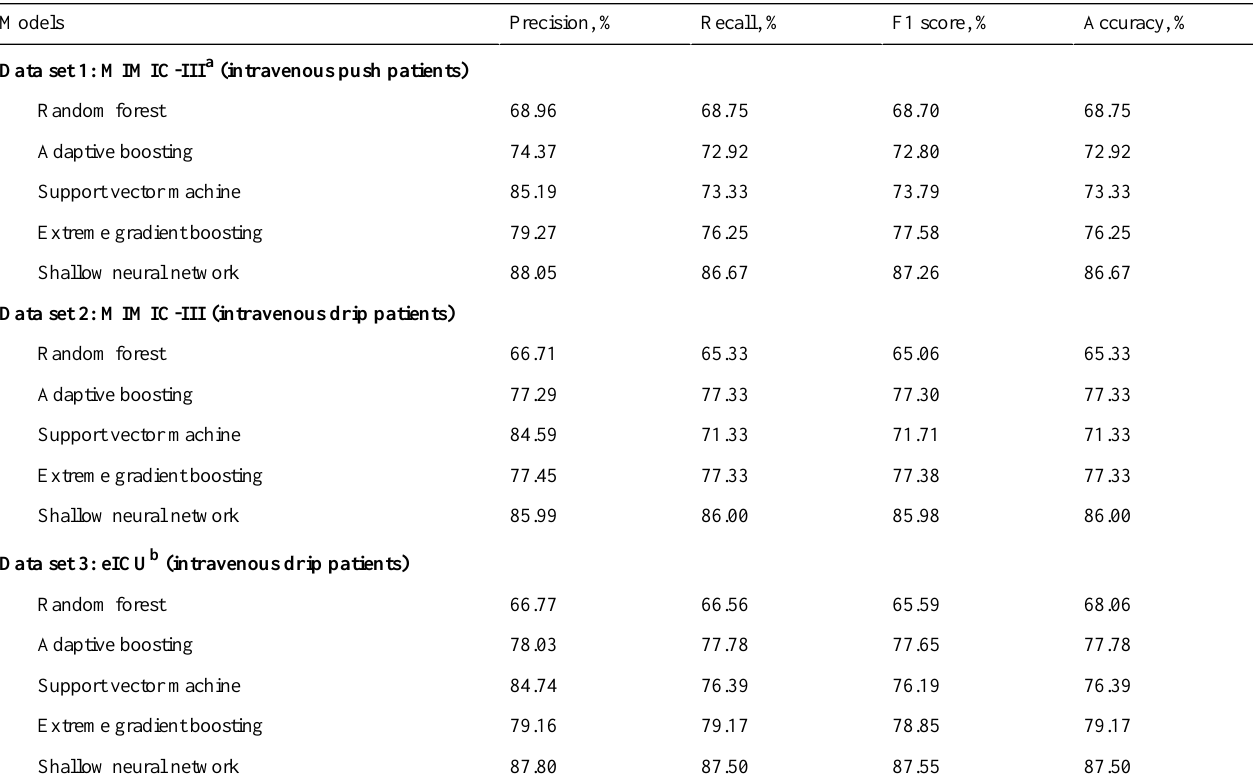
Table 2. Macroaveraged scores for the machine learning